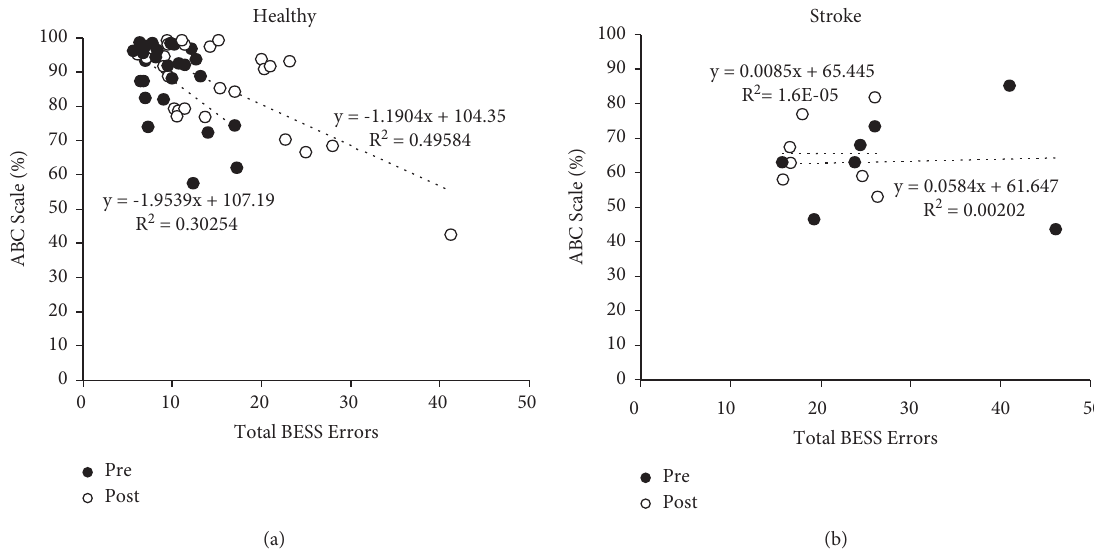
Figure 3: (a) 27 healthy and (b) 7 chronic stroke participants’ ABC Scale scores before (open circle) and after (filled circle) training versus total BESS errors; trendline and R 2 values are